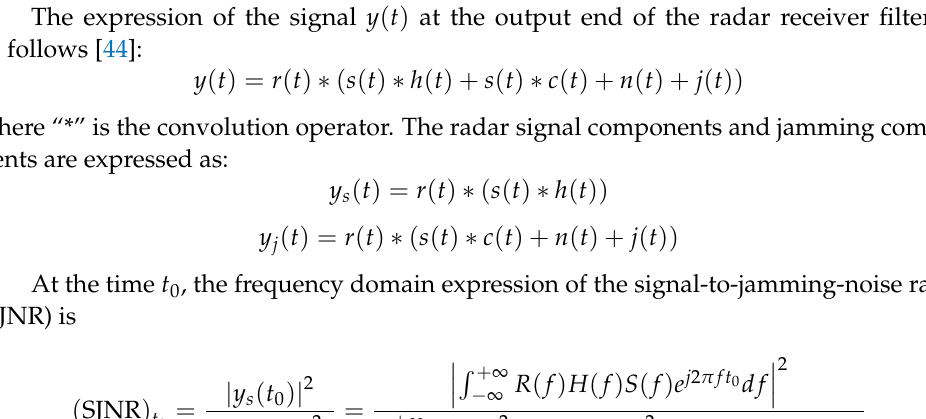
Figure 3. Airborne radar signal model.